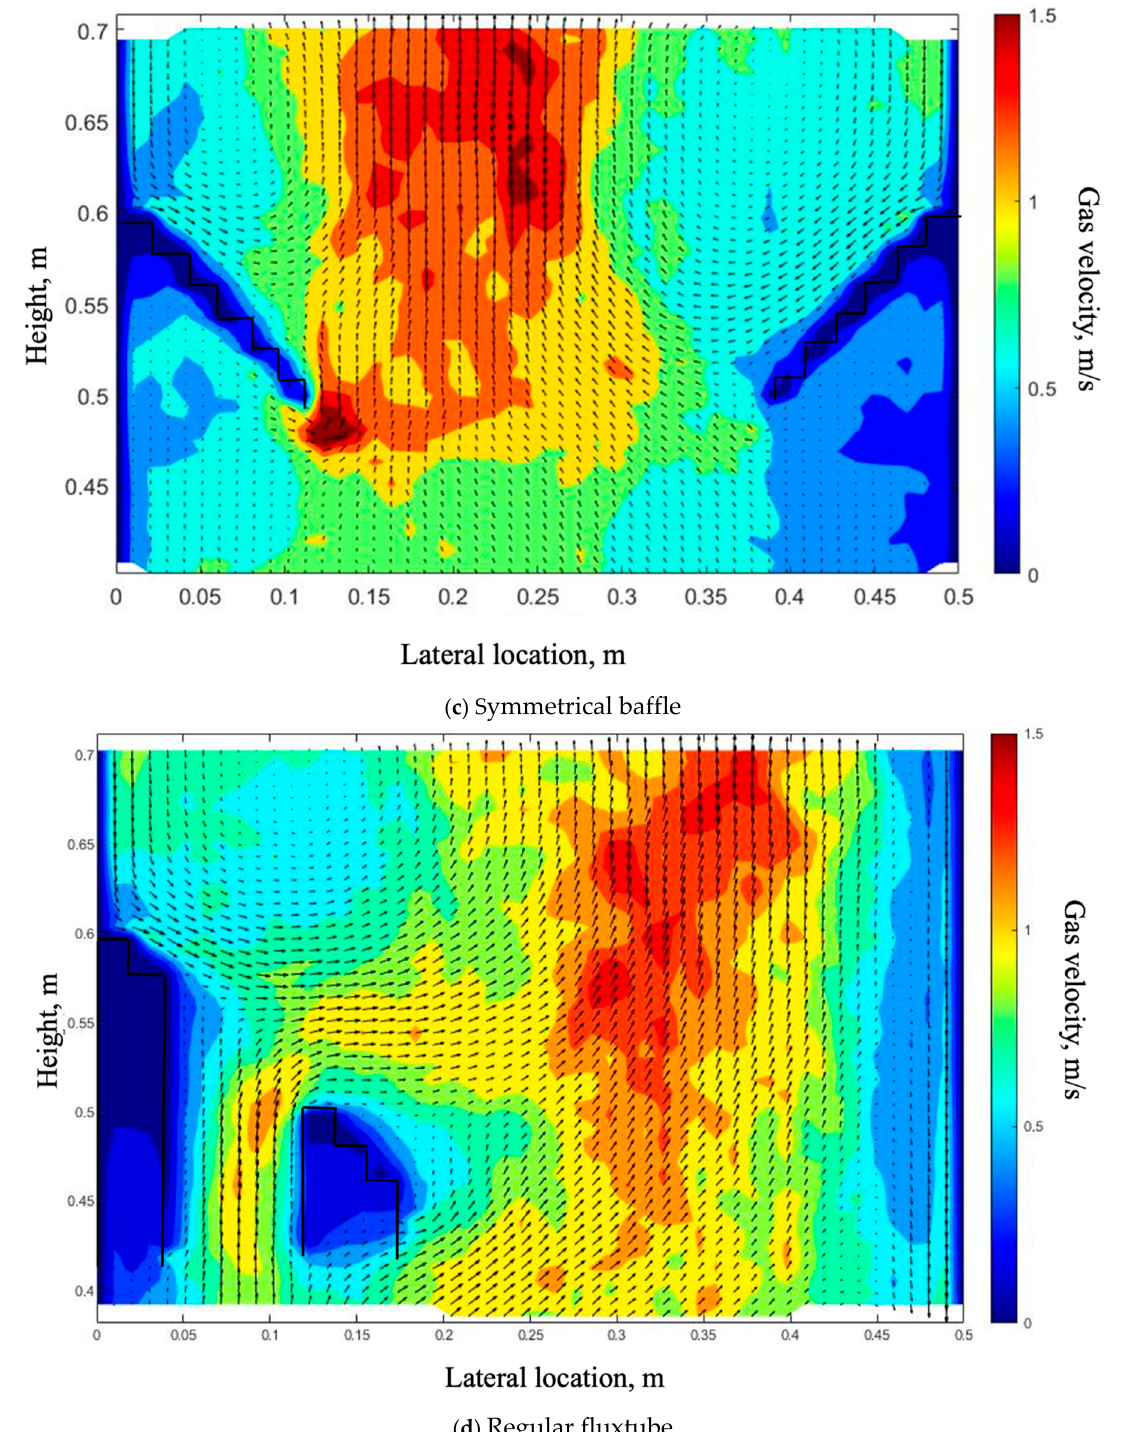
Figure 6. Gas velocity magnitude contours with velocity vectors at the baffle zone (0.40 m < y < 0.70 m) with and without baffle and regular fluxtube under the superficial gas velocity of 0.4 m/s using the even inlet gas distributor. Figure 7 shows the contours of the gas bubble distribution in the fluidized bed with and without baffles. It shows that all the baffles tested, with or without the fluxtube, can affect the gas bubble flow in the entire bed. The use of the baffles results in an increase in